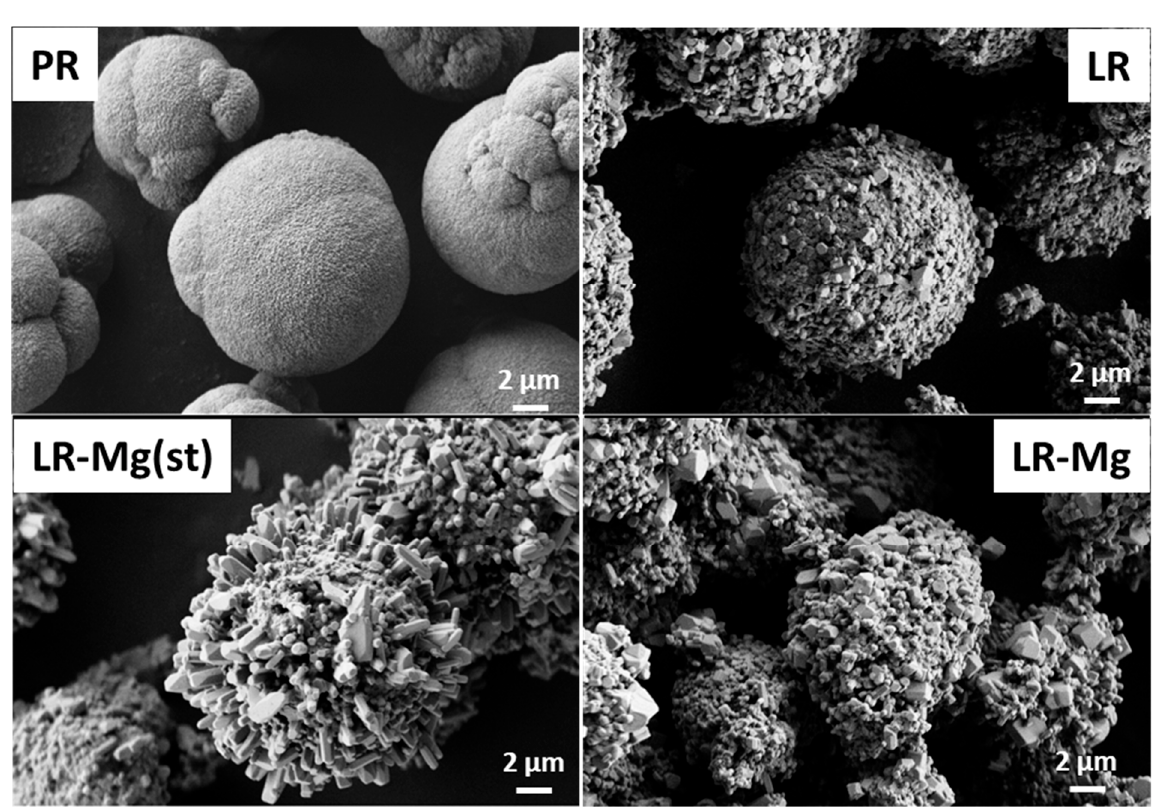
Figure 1. SEM images of the carbonate precursor for LR (PR) and of LR; LR-Mg; and LR-Mg(st) oxides (sample names are shown in the figures).